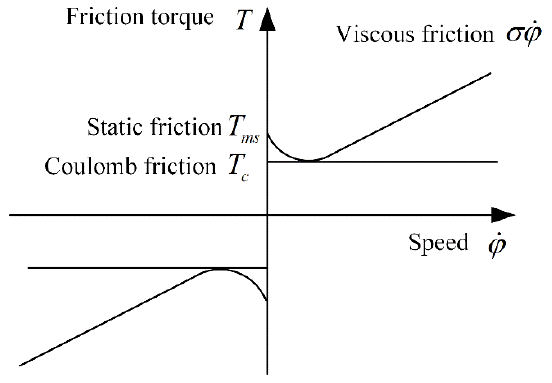
Figure 7. Stribeck friction model.